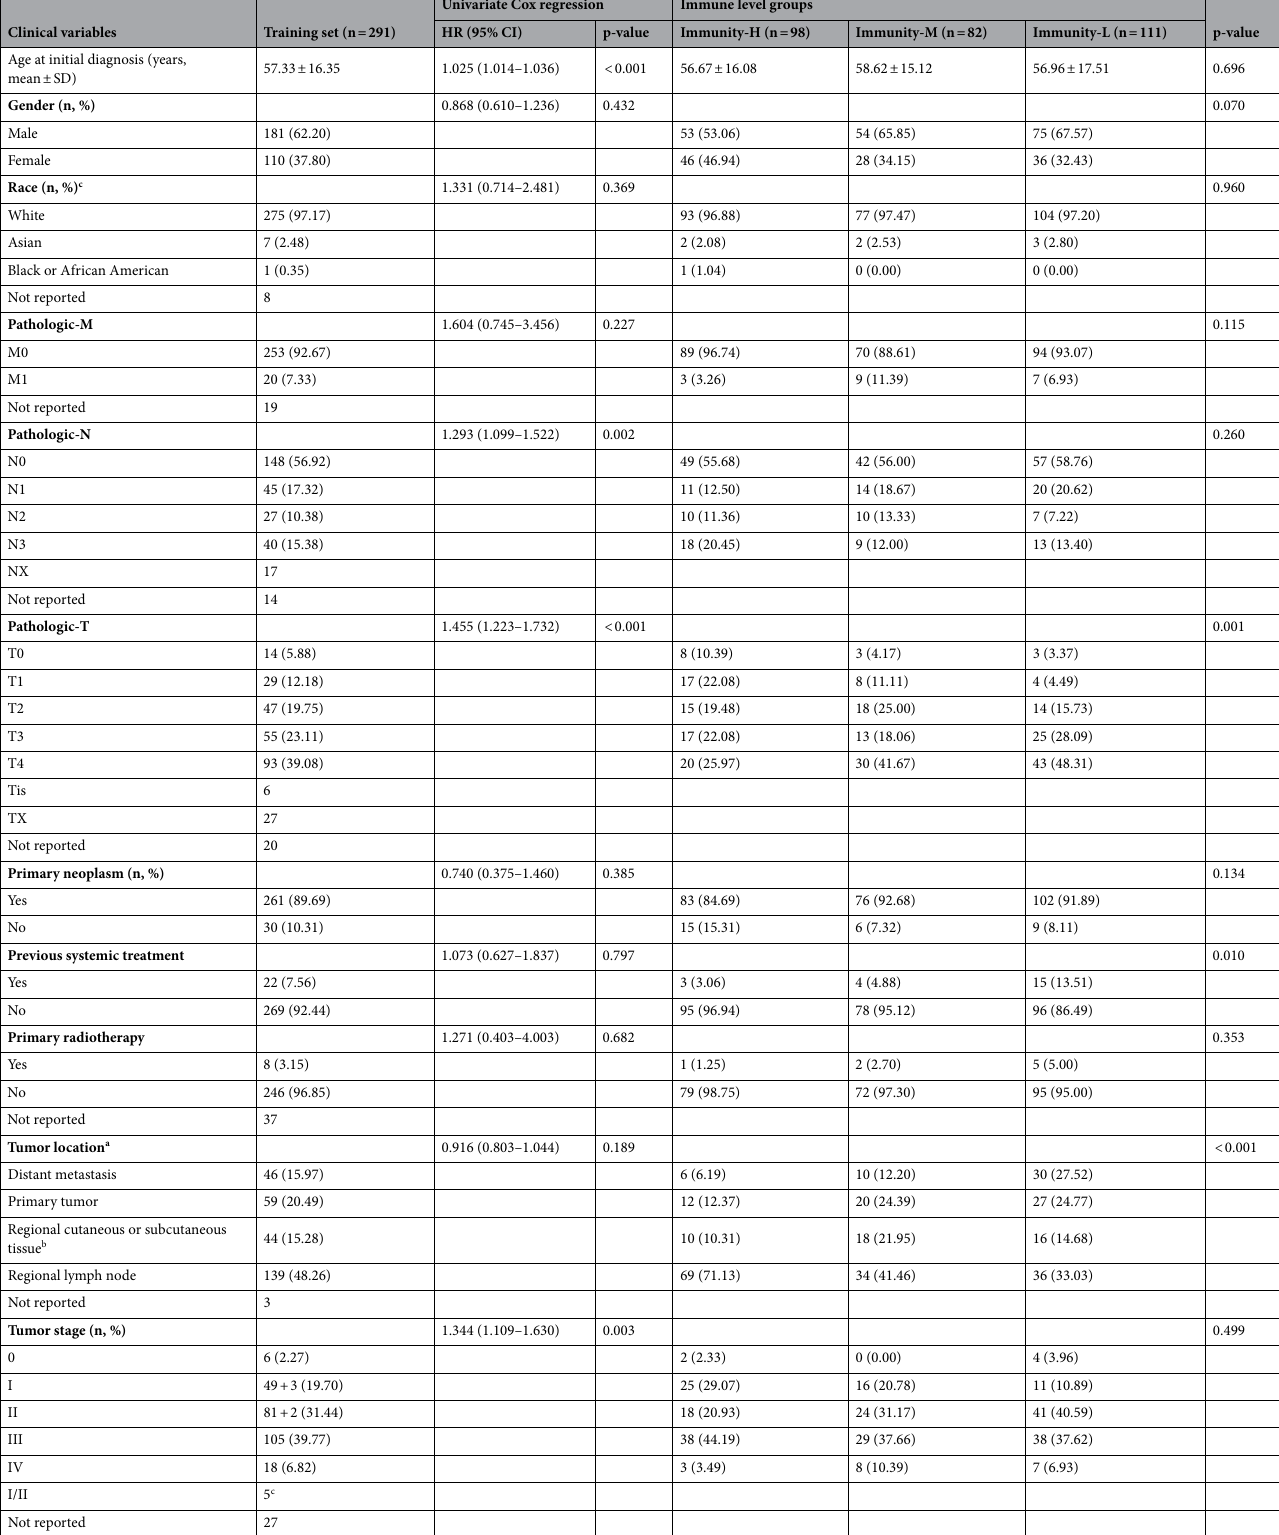
Table 1. Clinical characteristics and univariate Cox regression of overall survival and immune level grouping results of CM patients in the training set. HR hazard ratio, 95% CI 95% confidence interval, SD standard deviation. a Dummy variable. b Includes satellite and in-transit metastasis. c The 5 CM patients were randomly assigned to I (n = 3) or II (n =